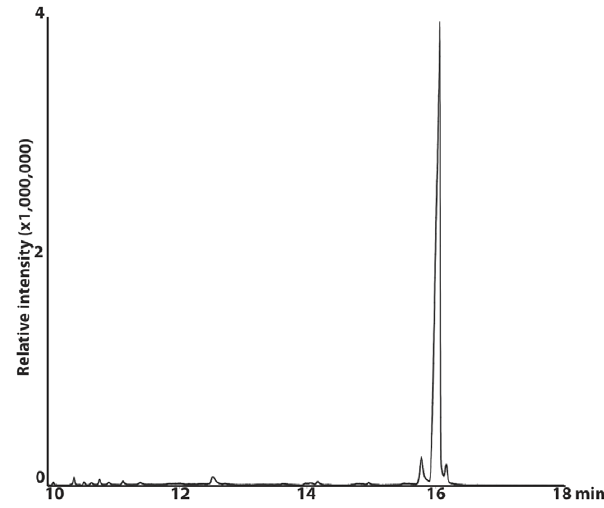
Figure 1. GC-MS traces of Diacetoxyscirpenol (DAS). Recon- structed ion chromatogram of an extract of 7 day-old liquid stage 2 cultures of F. sambucinum (T5). DAS elutes at 16.1 minutes.